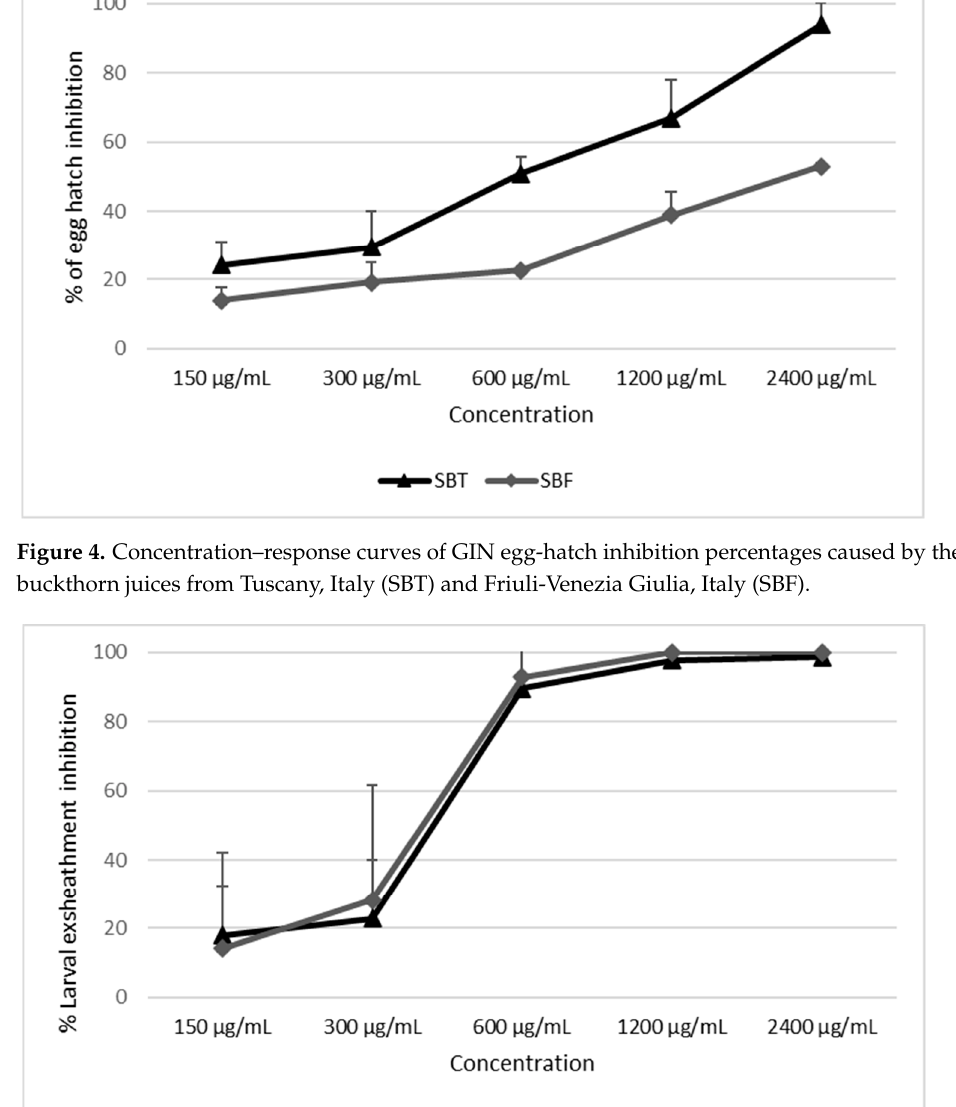
Figure 5. Concentration–response curves of the GIN larval-exsheathment inhibition caused by the